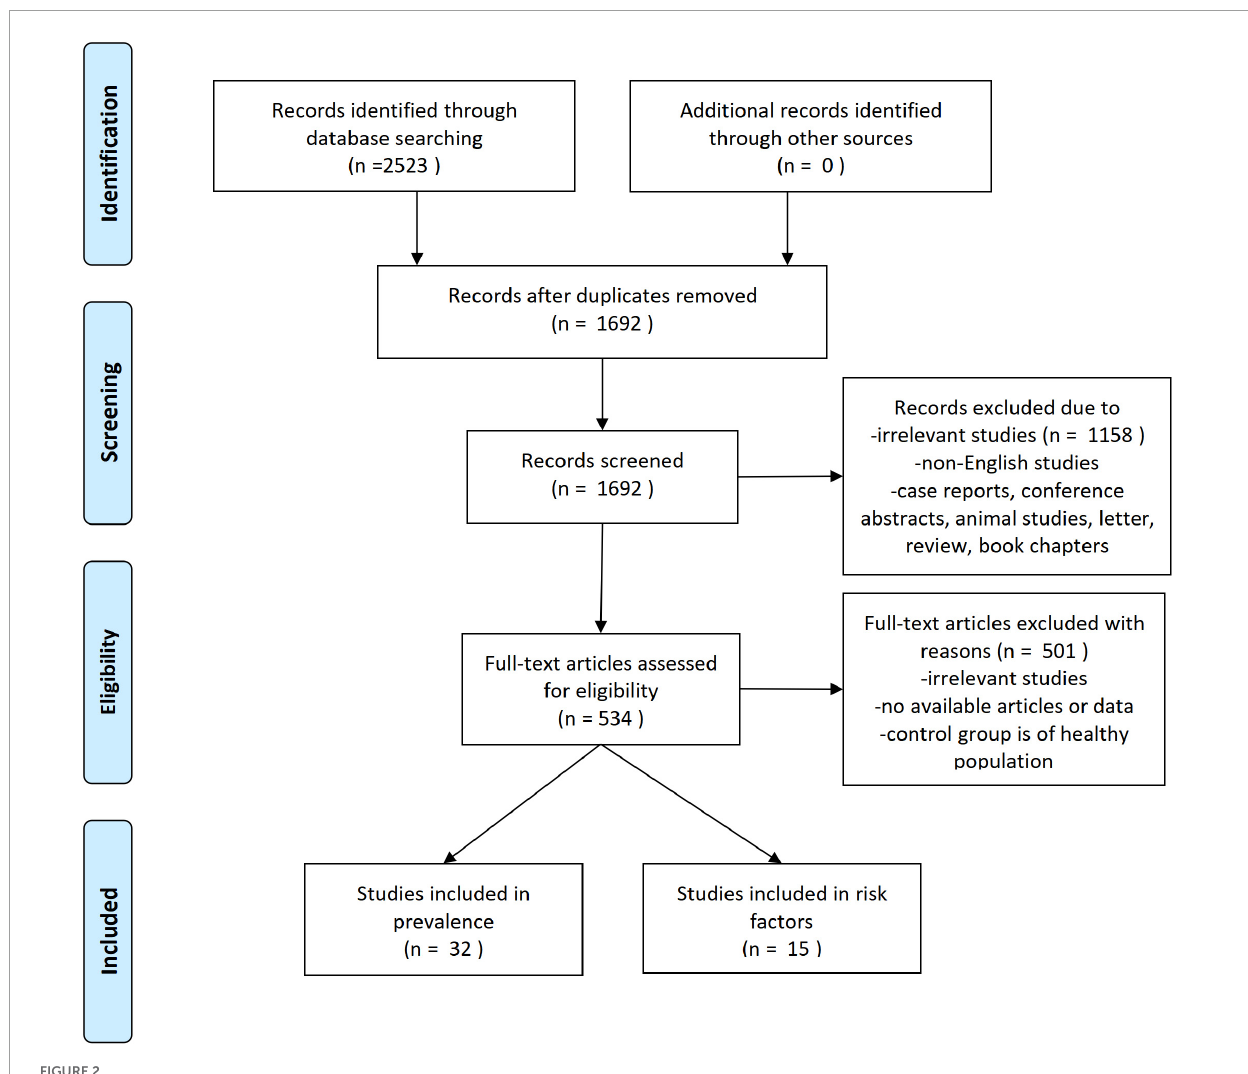
FIGURE2 Selection process for the studies included in the meta-analysis.